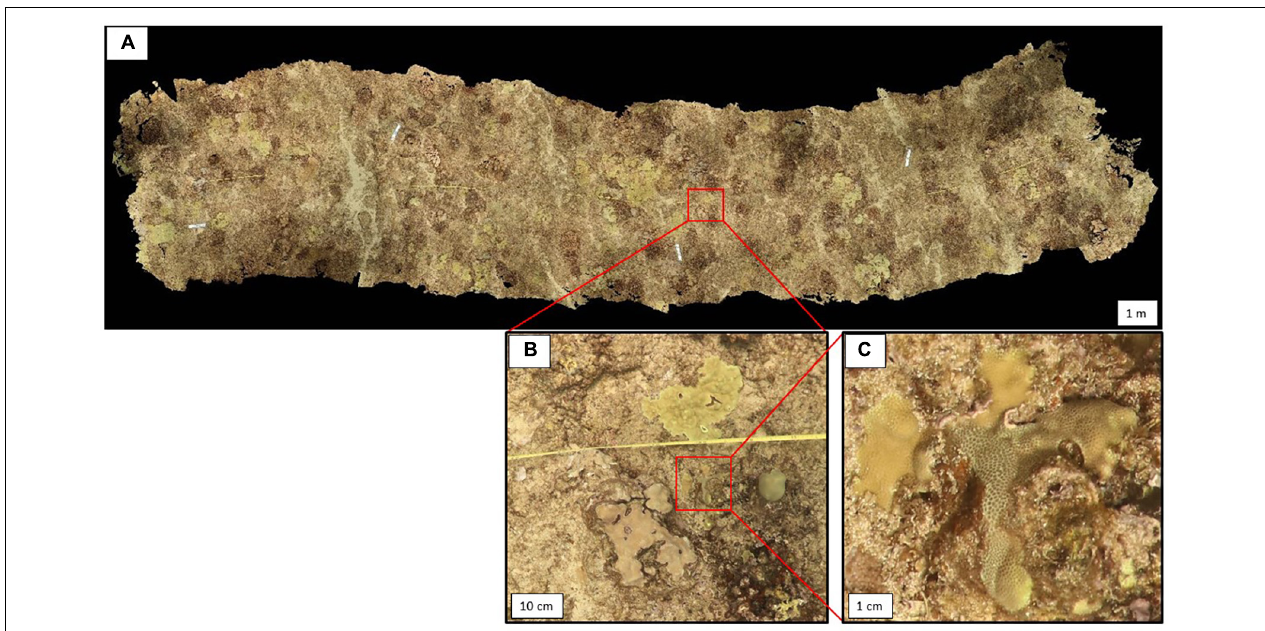
FIGURE 3 | (A) 60 m 2 orthoprojection and associated high resolution imagery (B,C) used to both create the orthoprojection and assist with coral colony annotation in ArcMap.